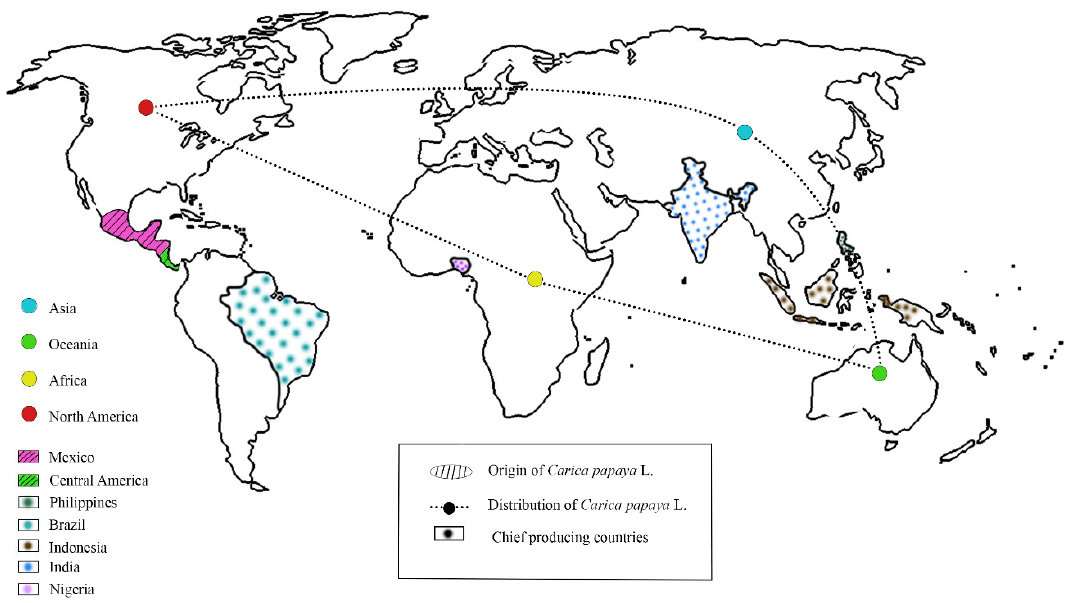
Figure 1. Carica papaya : World map showing the origin, distribution, and the chief production coun-